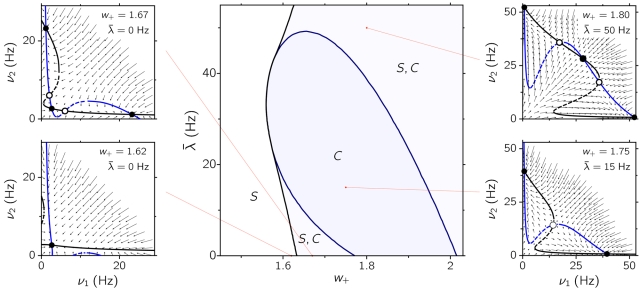
Central panel: Phase diagram of the system as given by the mean field approximation.In each region of the diagram, the presence of the different stable states is indicated by initials S (symmetric state) and C (competition, where both asymmetric states are present). In regions labeled with S,C there is tristability, all three states being simultaneously stable. Boundaries between regions correspond to bifurcation points at which either the symmetric state or the asymmetric states disappear (blue and black thick curves, respectively). Lateral panels show the fixed points, the flows, and the nullclines of the effective 2-dimensional reduction of the system (see Materials and Methods), for different representative points in the phase space. Filled and empty circles denote the stable and unstable fixed points of the reduced system. Black and blue curves are the nullclines ν ˙2 = 0 = 0 (horizontal flow) and ν ˙1 = 0 (vertical flow), respectively.